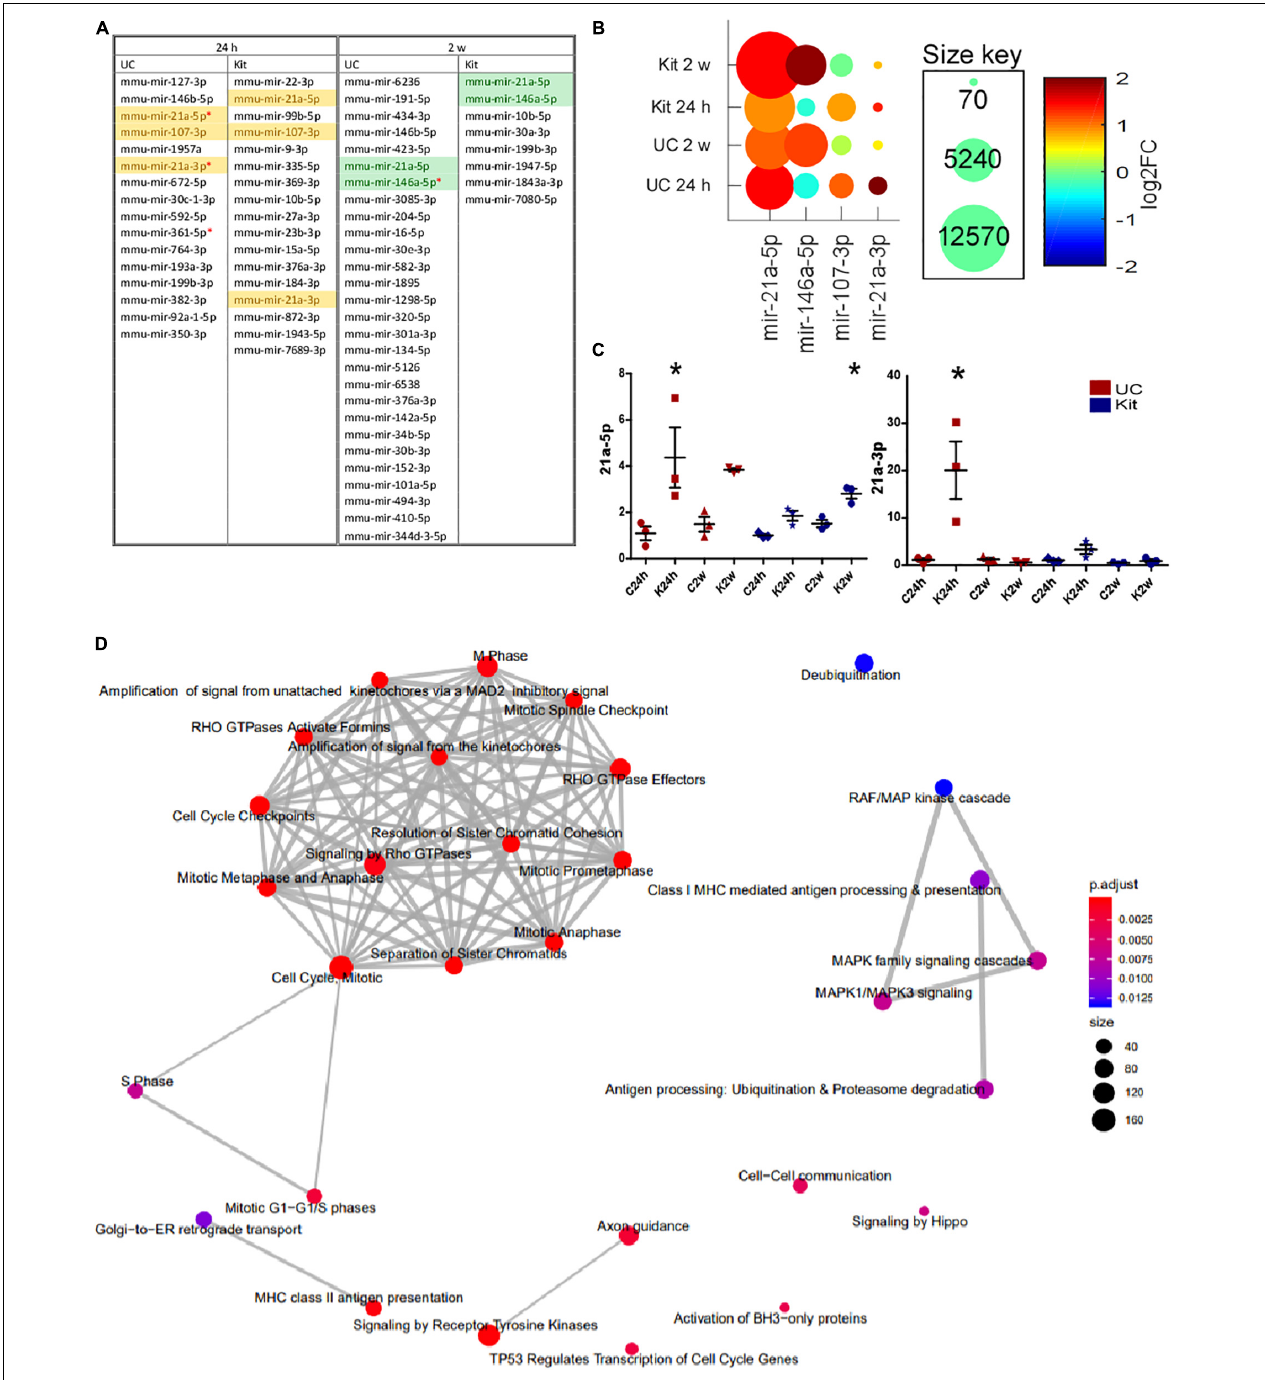
FIGURE 7 | Differential expression of miRNA in EEFs after status epilepticus. (A) The table shows miRNA which were detected as differentially expressed between control and KA at 24 h and 2-weeks, at unadjusted p -value ≤ 0.05. Highlighted miRNAs are those differentially expressed in EEFs using both UC and kit methods. Red asterisk indicates miRNA which were differentially expressed at an adjusted p -value ≤ 0.05 in UC samples. (B) Conserved miRNA changes after status epilepticus. The graph shows levels of miR-21a-3p, miR-21a-5p, and miR-107-3p (increased at 24 h), and miR-21a-5p and miR-146a-5p (increased at 2-weeks). Of these, significance for miR-21a-3p and miR-21a-5p at 24 h and miR-146a-5p at 2-weeks was only found in the UC method at an adjusted p -value of < 0.05. (C) Validation of sequencing results using individual miRNA assays confirming increased miR-21a-5p and -3p. UC, in red; kit, in blue. miRNA levels are normalized to average of 25-3p and 92b-3p. Graphs show mean ± SEM. ∗ p < 0.05 comparing to matching control. n = 3 per group using the same samples as were sequenced (ANOVA with Bonferroni post hoc test). (D) Network map of GO terms significantly enriched among the targets of the four miRNAs (miR-21a-3p, miR-21a-5p, miR-107-3p, and miR-146a-5p). The network was generated using ReactomePA R/Bioconductor package. The node color indicates the significance of the enrichment (adjusted p -value) while the node size indicates the number of miRNA targets were found in that GO term category.